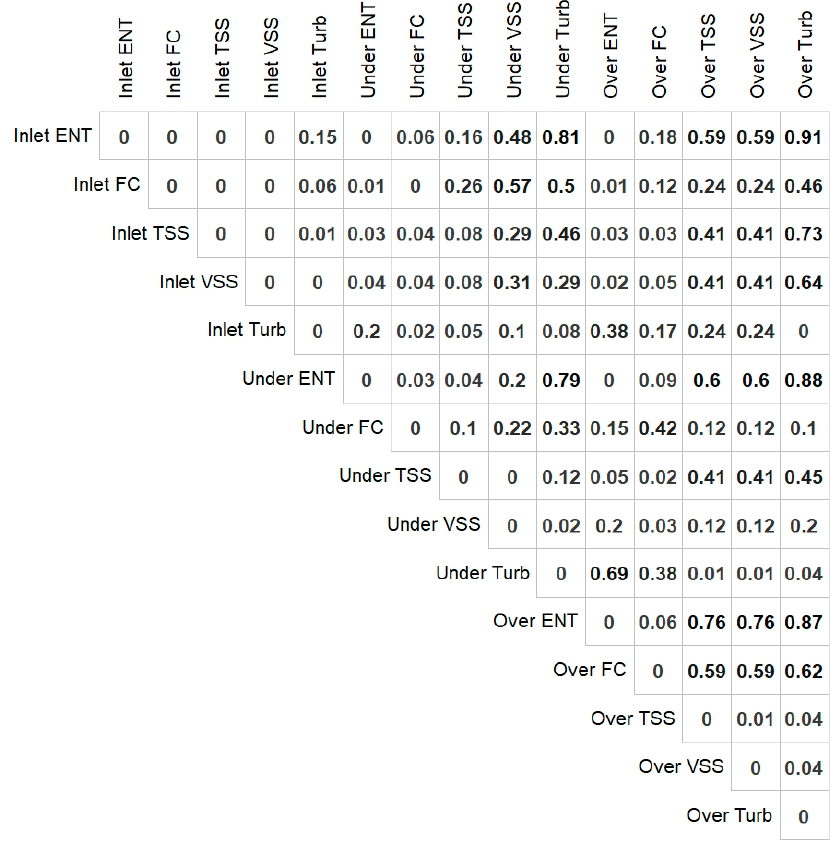
Figure 8. Kendall’s Tau p -value correlation matrix for all pollutants (a = 0.05).